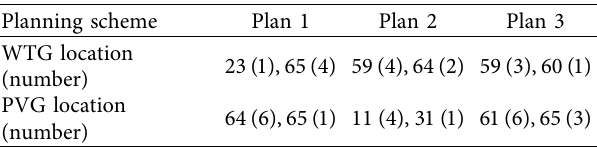
Figure 7: Regional measurement data. (a) Wind speed. (b) Optical radiation. Table 3: Program results. Table 4: Cost